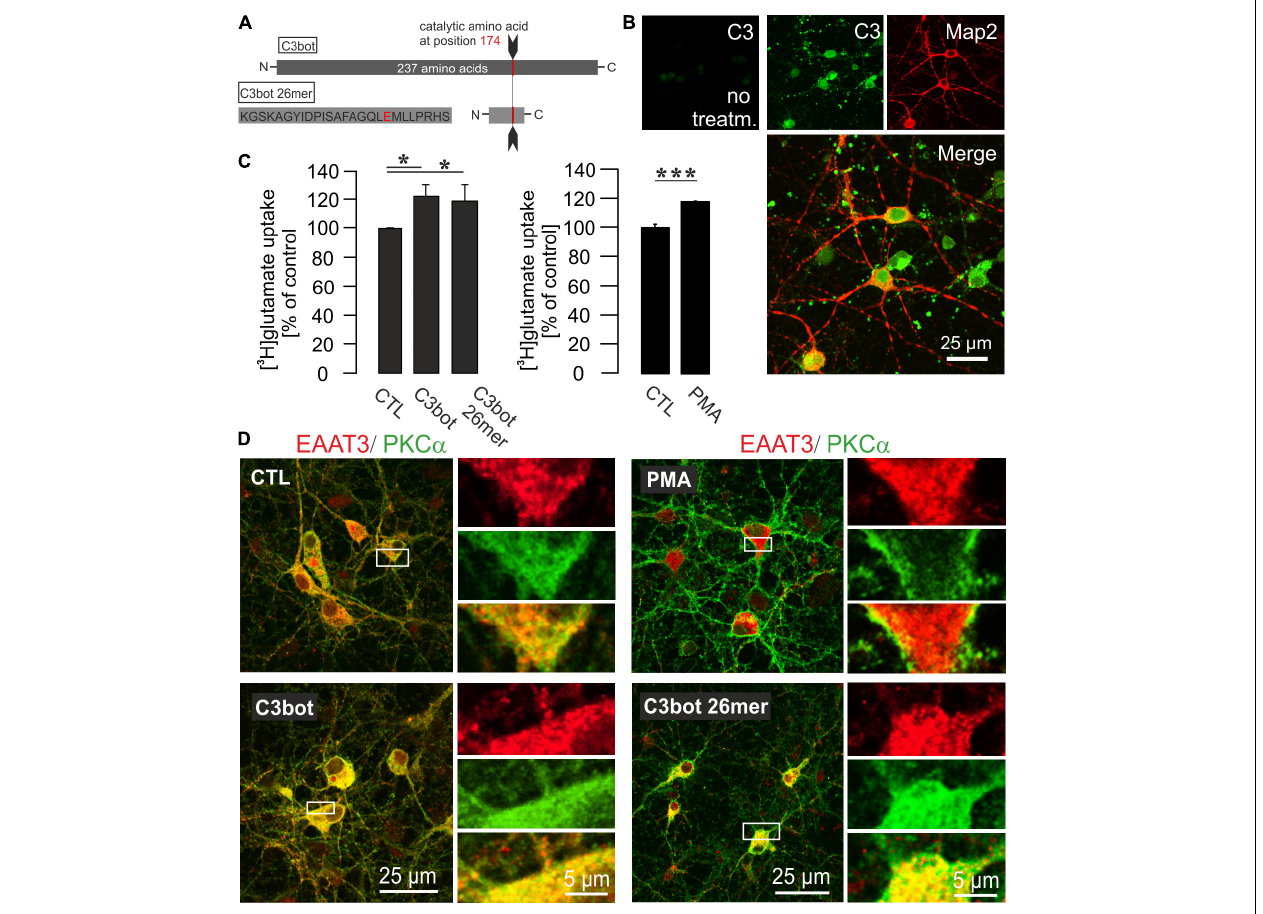
FIGURE 3 | Influence of C3bot, C3bot 26mer, or PKC activation on enhancement of glutamate uptake in hippocampal neurons. (A) C3bot 26mer covers the amino acids 156-181 of C3bot full length. Glutamate at position 174 is the catalytic amino acid that renders full length C3bot enzymatically active. (B) In cultures treated with C3bot full length protein presence of the C3 transferase was visualized after 72 h by a specific antibody directed against C3 protein. The C3bot signal was mainly detected at the somata and Map2-negative processes probably representing axons in a mixture of internalized and surface bound protein. Confocal imaging. (C) Hippocampal neurons were incubated with 50 µ M [ 3 H]glutamate and uptake was measured as described before. Incubation with 300 nM of C3bot or C3bot 26mer for 3 days showed similar effects on uptake regulation. Following incubation with C3bot full length or C3bot 26mer transport activity was increased by C3bot (22%) and, slightly less, by the 26mer (19%). Prior to the uptake procedure, part of the cells were incubated for 30 min with 200 nM of the activator of PKC isoforms PMA. Preincubation with PMA increased the uptake by 19%. In addition, cells were preincubated with dihydrokainate (DHK, 1 mM for 30 min) prior to the uptake procedure to selectively block EAAT2 transport activity. Values therefore represent PDC- and DHK-sensitive counts (analyzed in triplicates) expressed as means ± SEM from 4 to 5 independent experiments. * p ≤ 0.05; *** p ≤ 0.005. (D) Confocal imaging of PKC α and EAAT3 distribution in hippocampal neurons after treatment with C3bot, C3bot 26mer, or PMA. In control cells, PKC α showed a marked cytoplasmatic localization, indicative of inactive PKC α . Expression of EAAT3 was also detected throughout the whole cell. Addition of PMA resulted in a shift of PKC α to the plasma membrane characteristic for activation. Conversely, incubation with C3bot or C3bot 26mer did not result in activation of PKC α . Distribution of EAAT3 remained unchanged after either